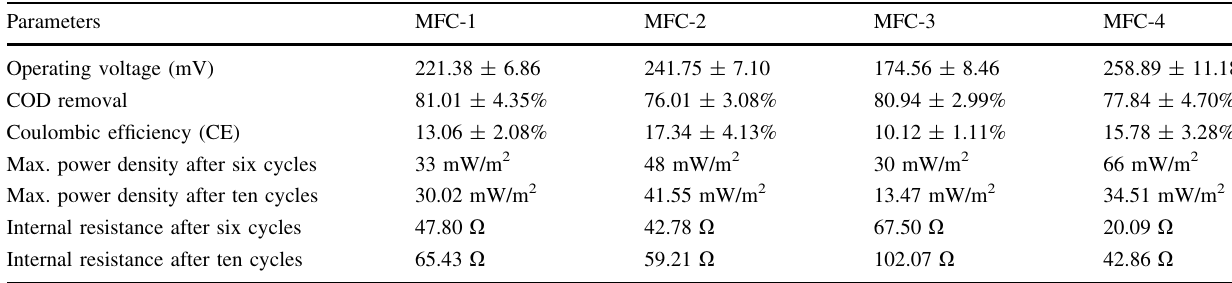
Internal resistance after six